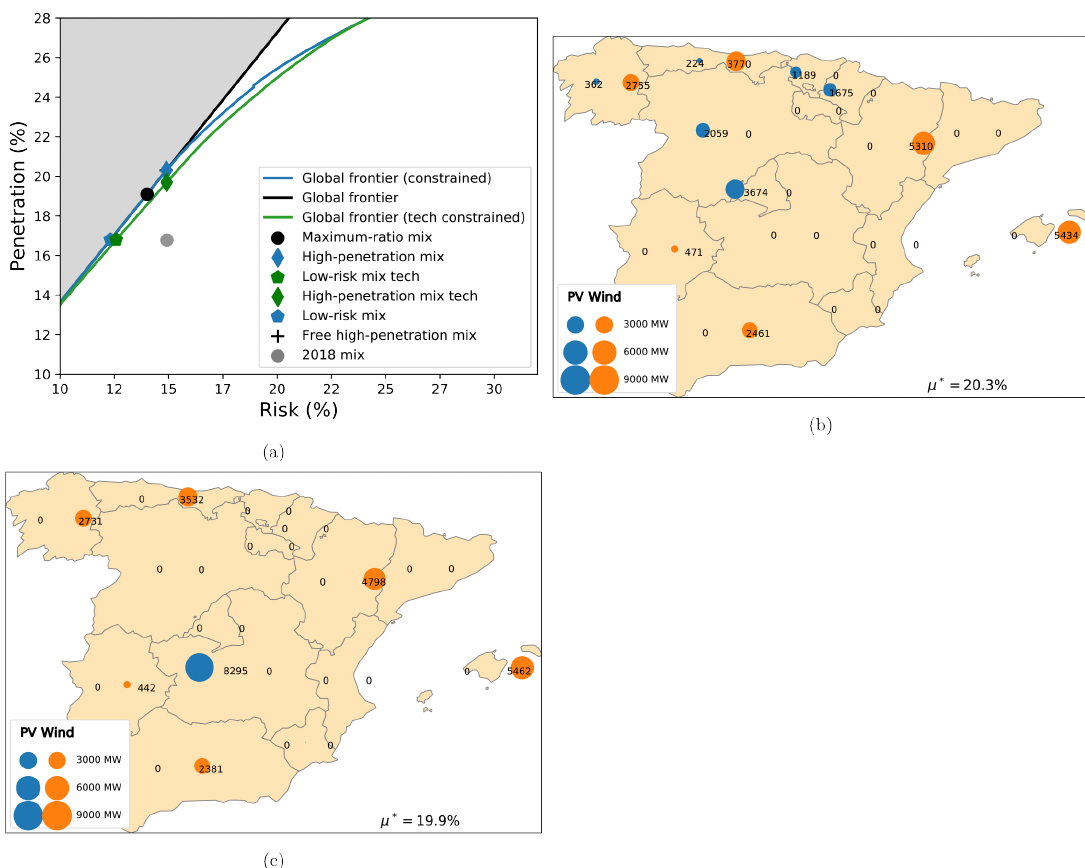
Figure 6. NEW/PV ( a ) penetration-risk diagram and ( b ) high-penetration mix.